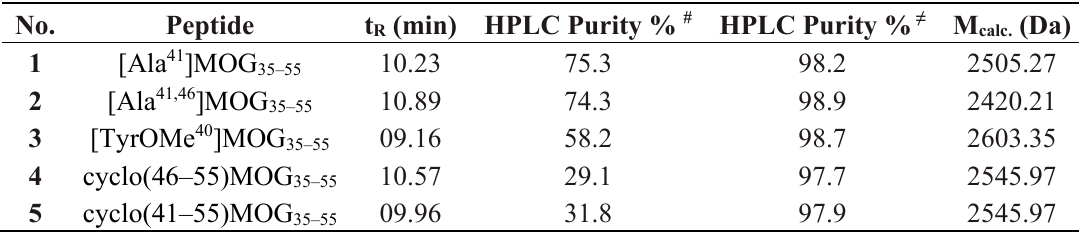
Table 1. Analytical data of the synthesized linear and cyclic